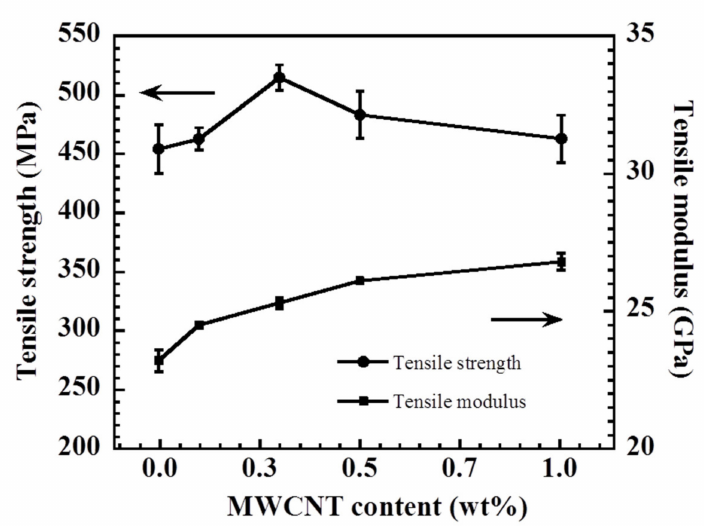
Figure 5. Summary of tensile property data collected for aramid fabrics that were reinforced with poly(BA-a/PU) composites containing different loadings of